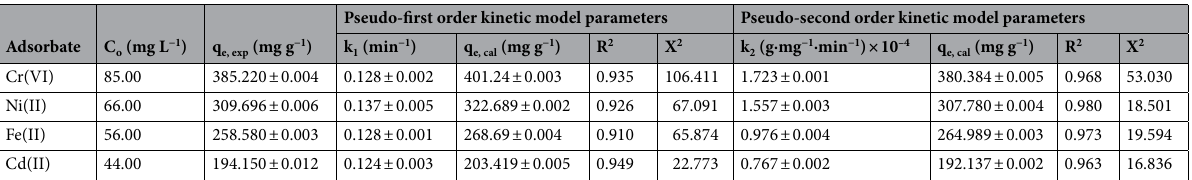
Table 4. Calculated kinetic model parameters for metal ions adsorption by MWCNTs-KIAgNPs.